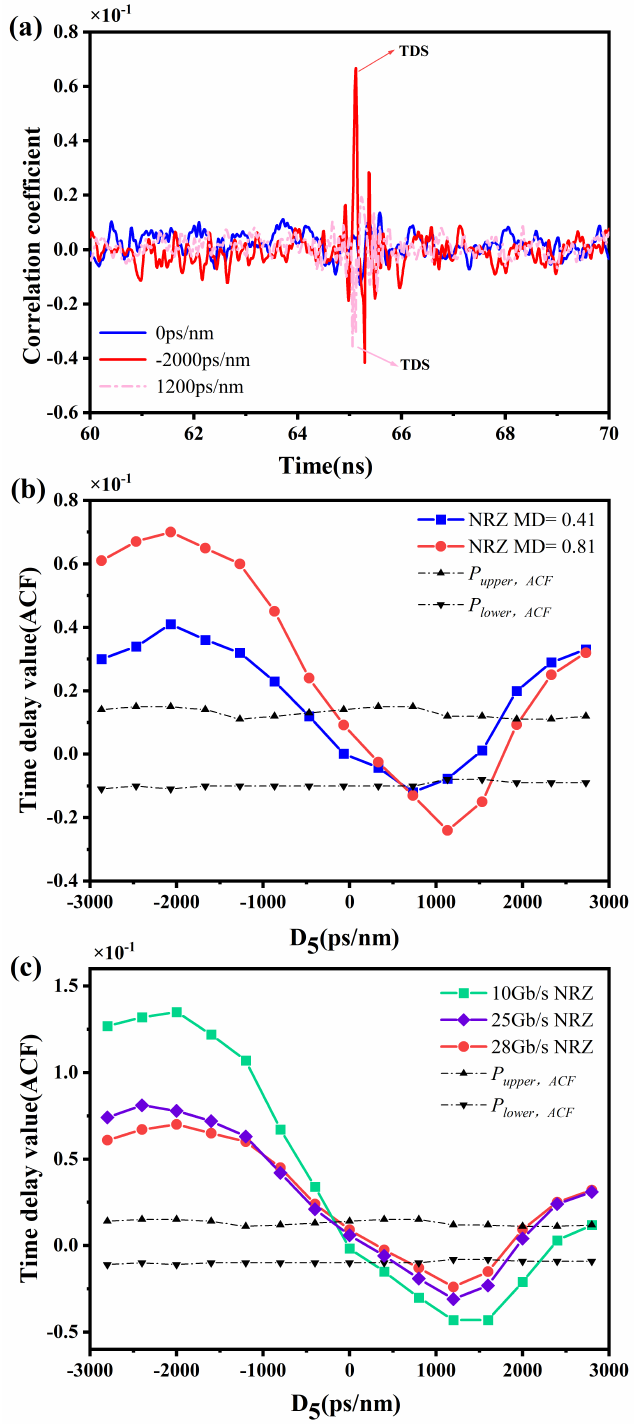
Figure 2. ( a ) ACF curves for different dispersion values of D5; ( b ) TDS peak value of the ACF versus D5 for NRZ data format with different MDs; and ( c ) TDS peak value of the ACF versus D5 for NRZ data format with different signal